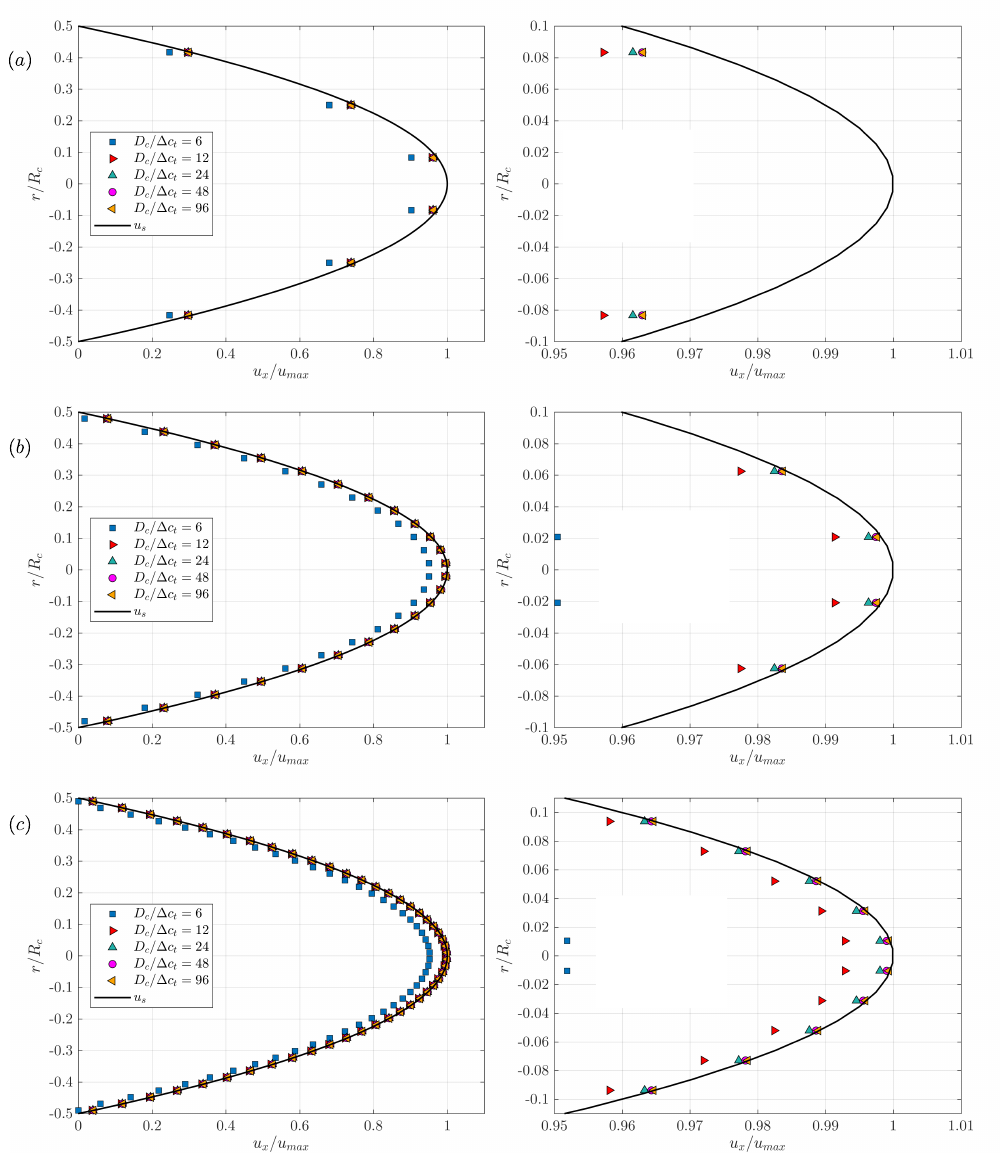
Figure 8. Influence of the triangle characteristic size ∆ c t on the convergence of the velocity profiles: ( a ) D c / ∆ x = 6, ( b ) D c / ∆ x = 24, ( c ) D c / ∆ x =